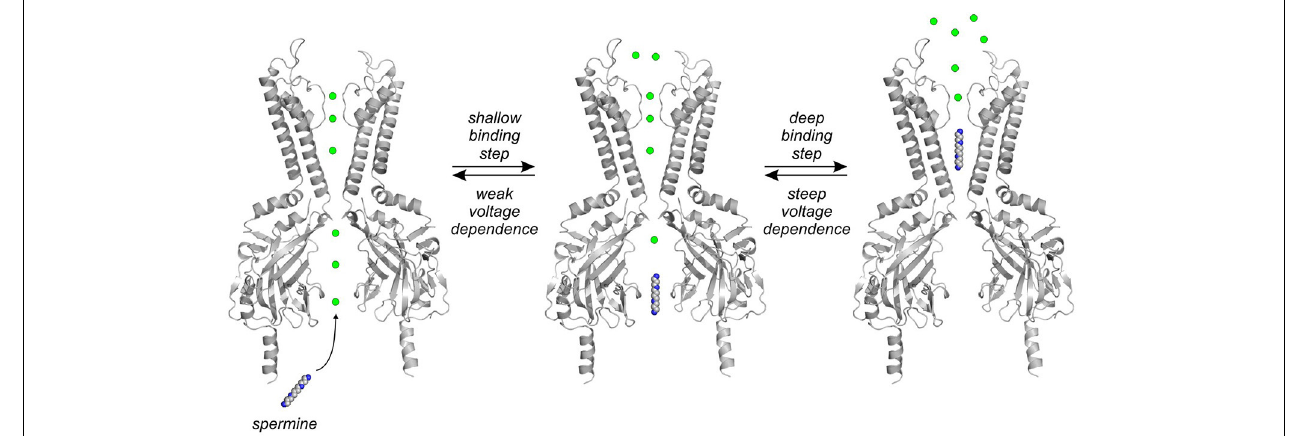
FIGURE 3 | Schematic diagram of polyamine migration and coupled ion movement. Spermine and other polyamines migrate through the channel pore toward a binding site in the TMD, and displace occupant ions ahead of them in the pore. The first binding step involves a low affinity interaction between spermine and various residues in the CTD.